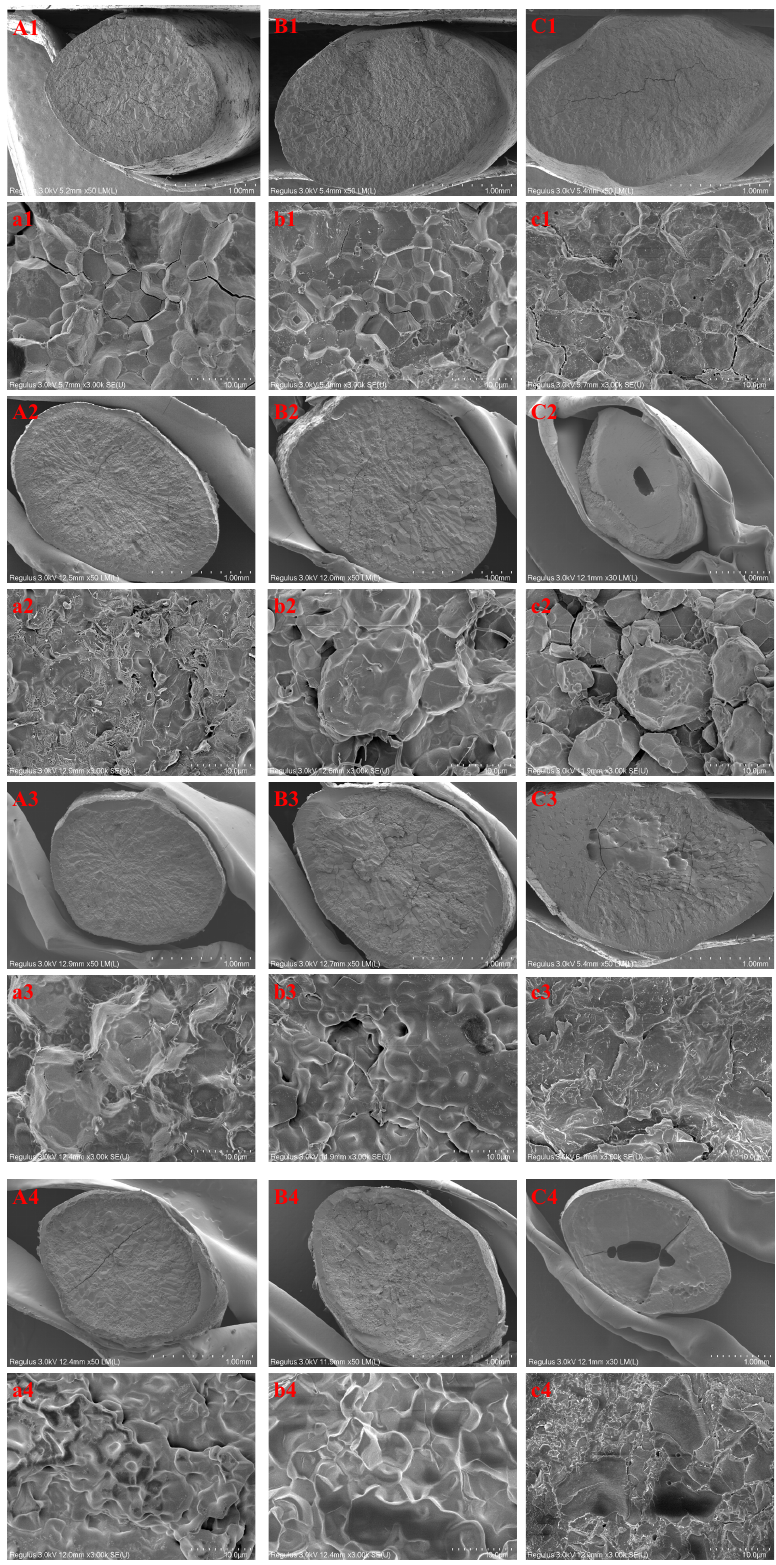
Figure 2. SEM images of different varieties of rice grains (indica, japonica, and waxy rice, coded “( A )/( a ), ( B )/( b ), and ( C )/( c )”, respectively) subjected to RF treatment at different treatment times (0, 10, 20, and 30 min, coded “1, 2, 3, and 4”, respectively). ( A – C ): the general profile of the cross-section; ( a – c ): partially enlarged view.